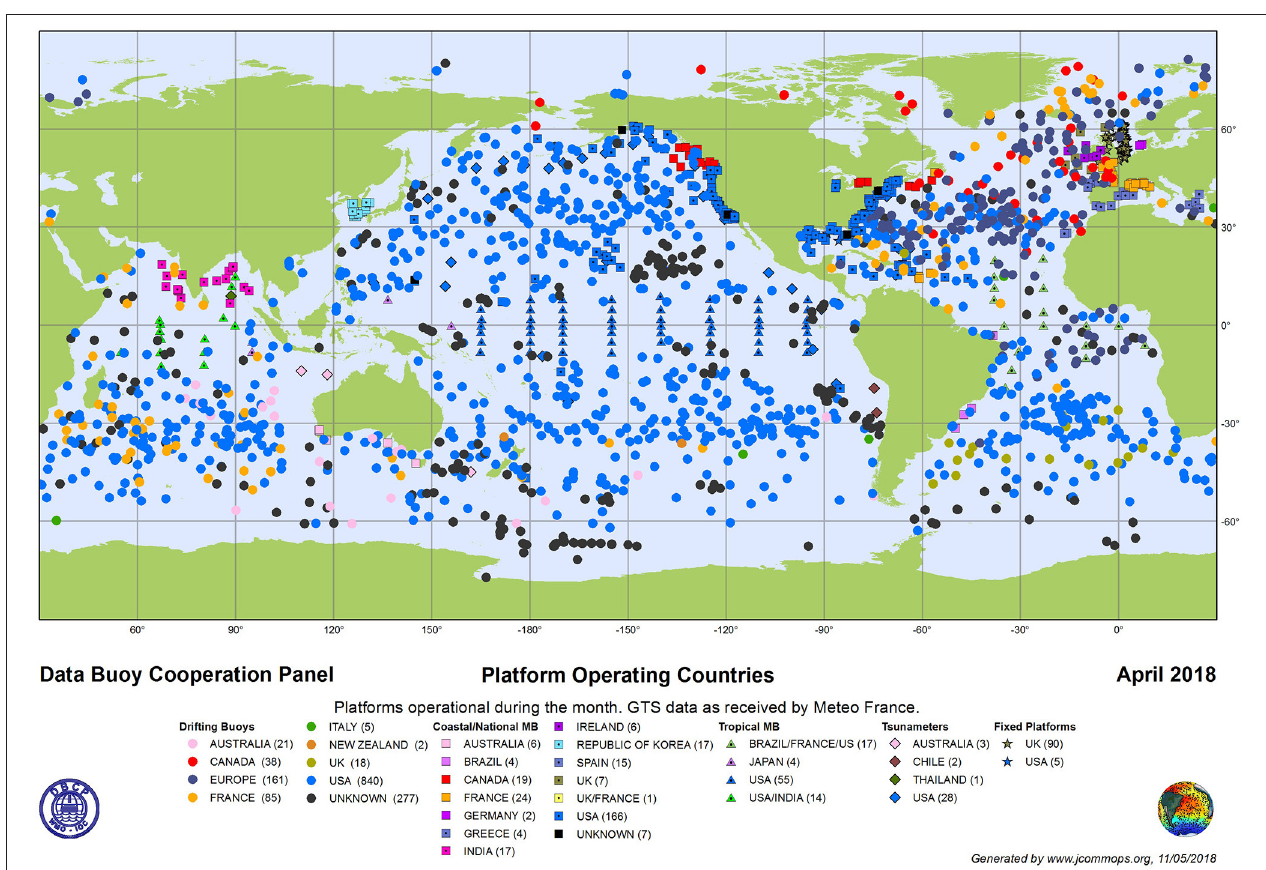
FIGURE 1 | Moored observatories in Global Oceans with permission of (Data Buoy Cooperation Panel,